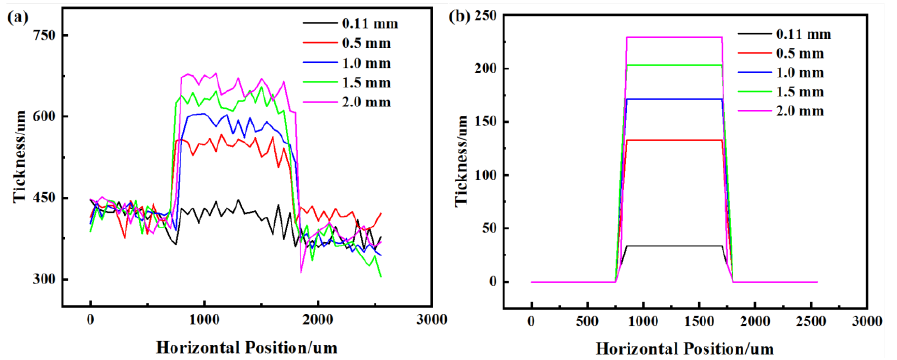
Figure 9. Fitted and approximate contours for different initial gaps at 6 kV discharge voltage. ( a ) Fitted profile; ( b ) Approximate profile.